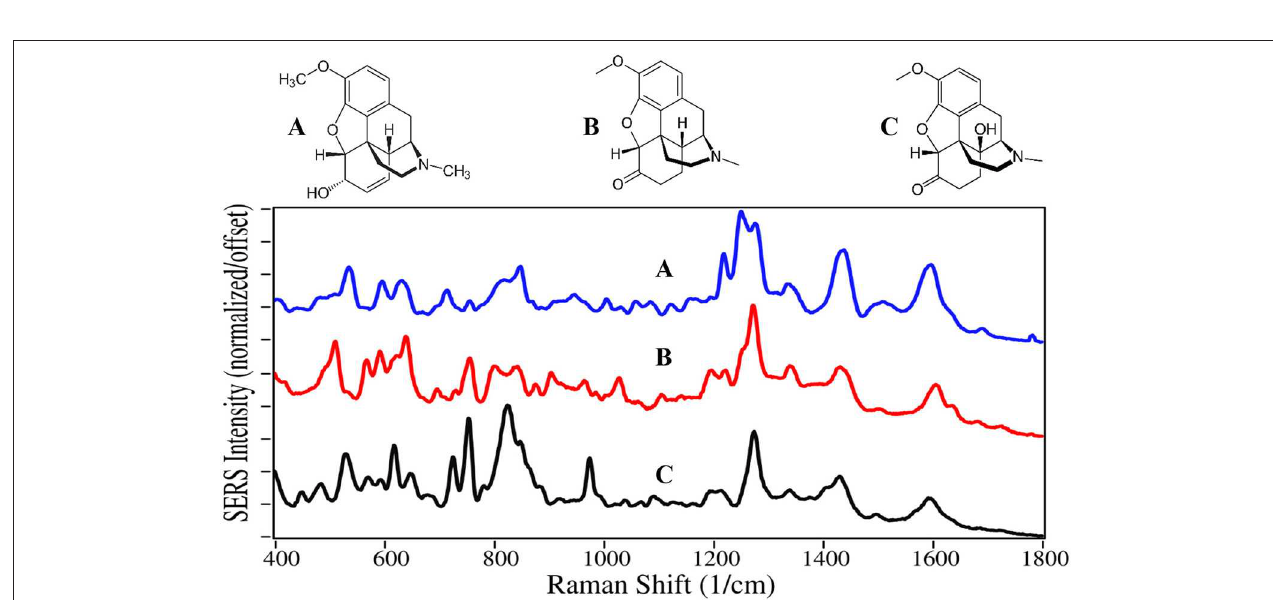
FIGURE 2 | Structures and 100 ppm SERS of (A) codeine, (B) hydrocodone, and (C)